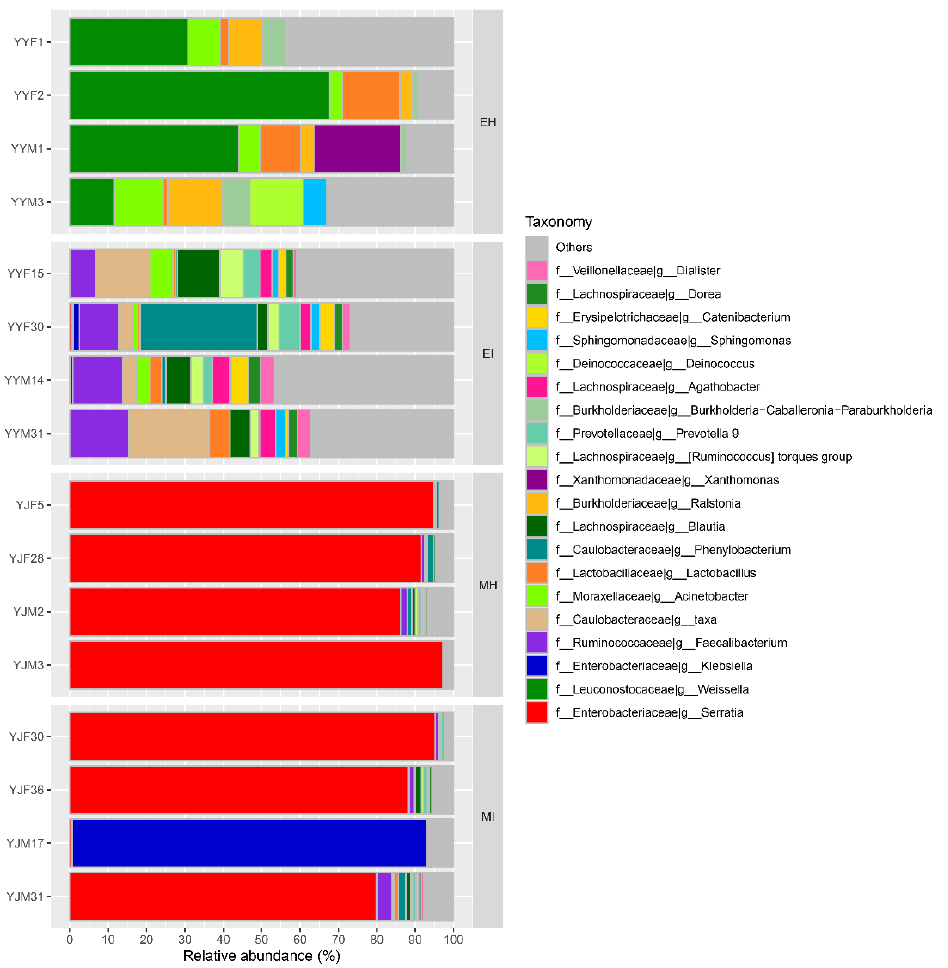
Figure 4. Relative abundance of dominant microbial genera (abundance ≥ 2%). The relative percentage of abundance of bacterial genera is represented by different colors. (EH: emergence period, healthy; EI: emergence period, infested; MH: mating period, healthy; MI: mating period, infested).